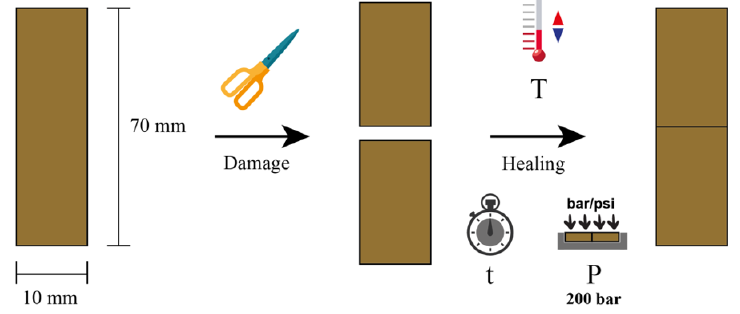
Figure 3. Scheme of the self-healing protocol.